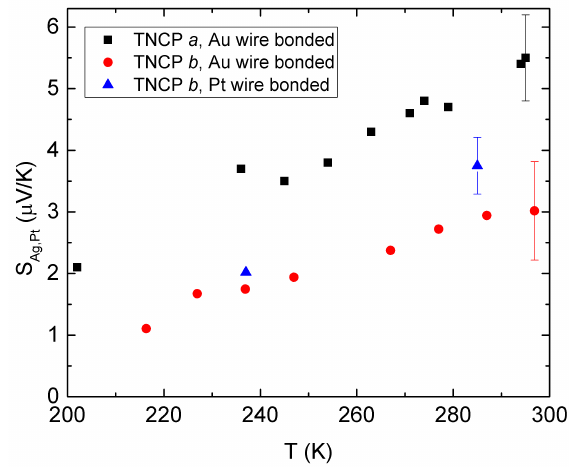
Figure 3. Ag nanowire Seebeck coefficient (with respect to Pt electrodes) and its temperature dependency, measured by TNCP a (data adapted from [16]) and TNCP b . The wires that bond the TNCP b pads to the peripheral electrodes are made from Pt or Au. The maximum error bar is depicted and was determined by fitting the minimum and maximum slopes, as a worst-case result (refer to Figure 8). Other methods (square root of covariance matrix) may lead to considerably lower